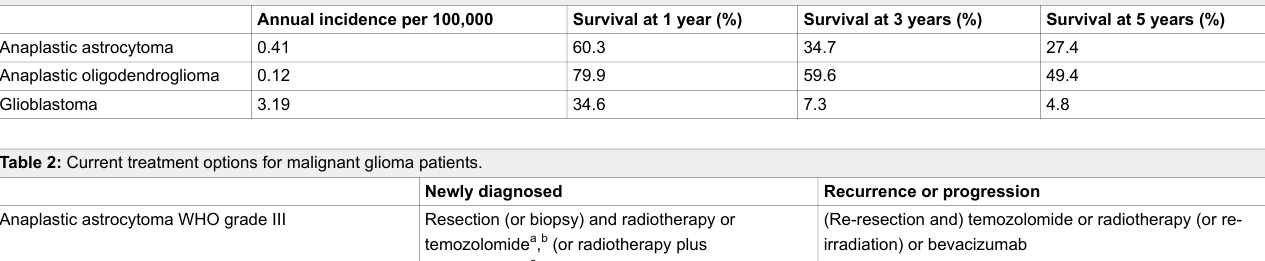
Table 1: Malignant gliomas: epidemiology and outcome (www.cbtrus.org).